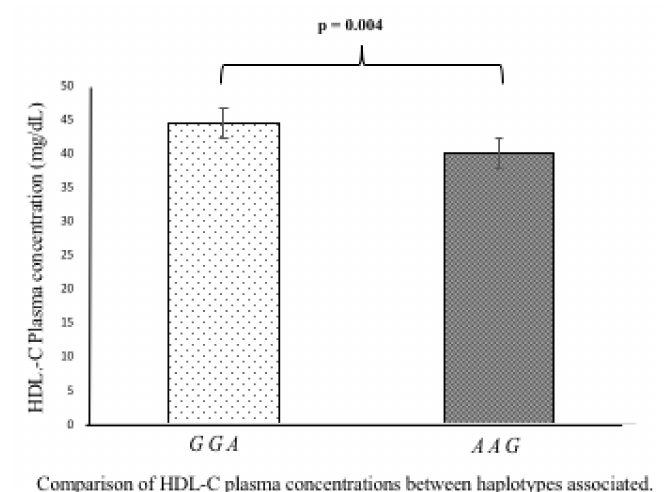
Figure 2. Contribution of the “ GGA ” and “ AAG ” on HDL-C levels. The “ AAG ” haplotype risk showed a lower concentration of HDL-C in plasma when compared to “ GGA ” haplotype of low risk ( p =